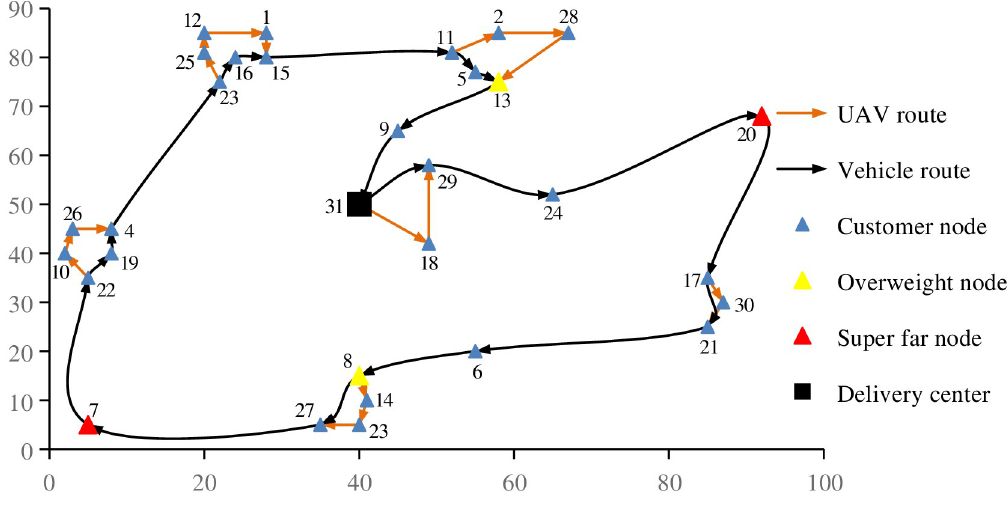
Fig 4. Results of UAV-vehicle joint